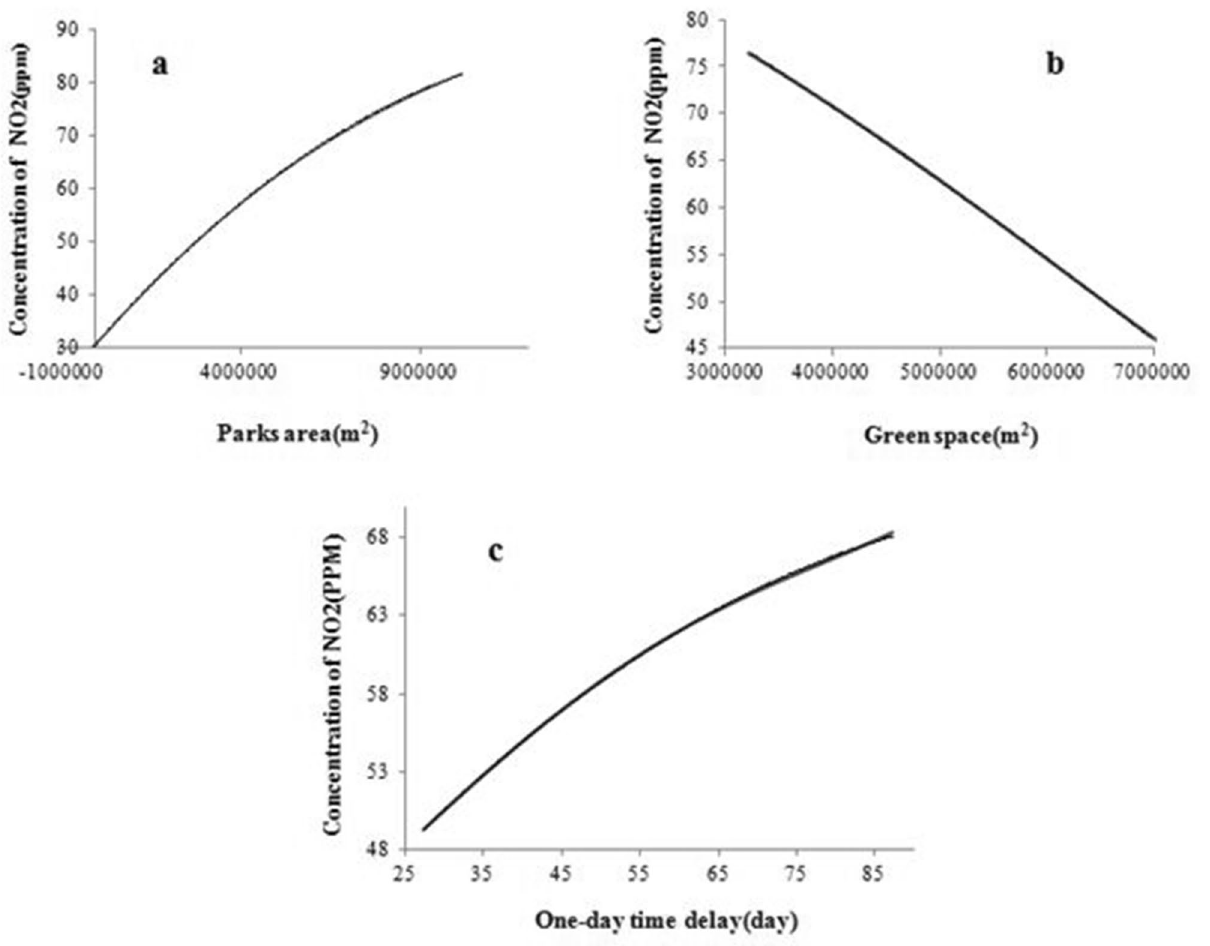
Figure 4. The trend of NO 2 prediction output changes with varying ( a ) parks area ( b ) green space. ( c ) One-day time